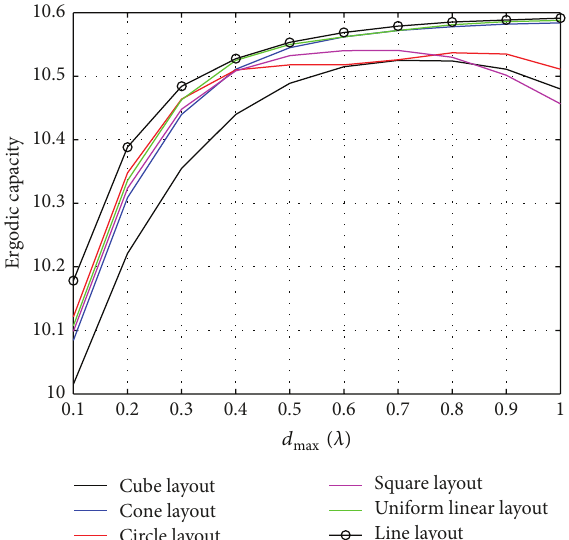
Figure 9: Capacity difference between the optimal layout and the reference regular layouts for Scenario III. 𝛾 0 = 20 dB.